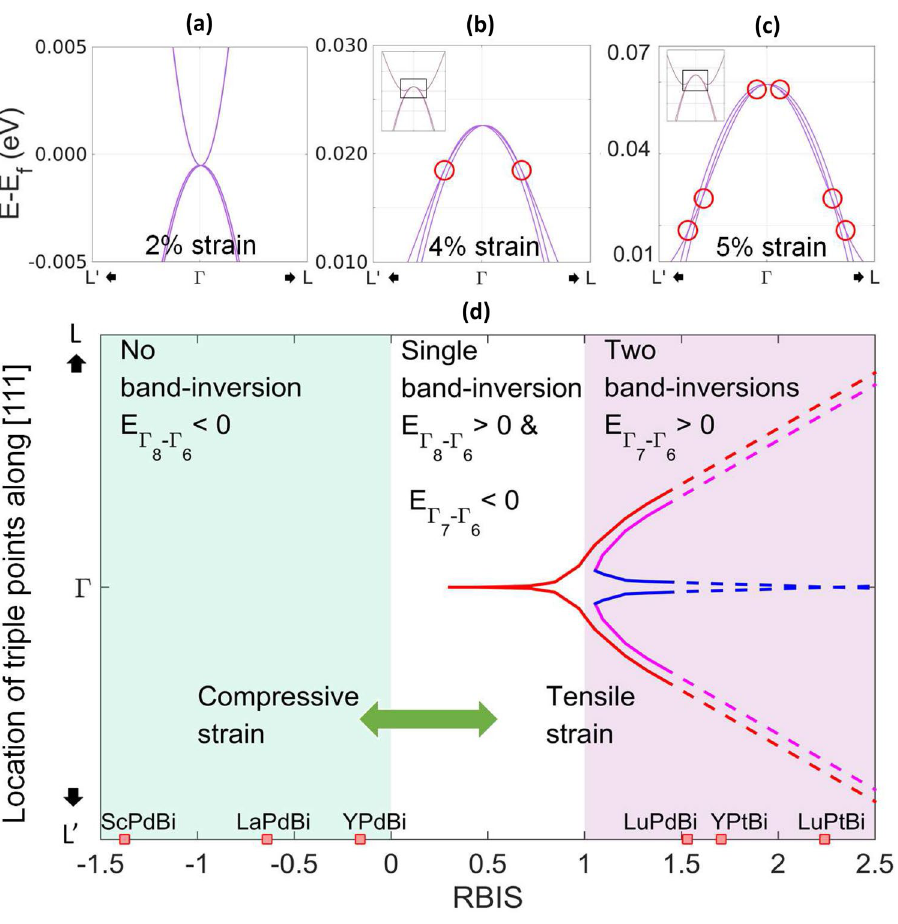
Figure 4. Triple points (marked with red circles) in YPdBi at ( a ) 2%, ( b ) 4% and ( c ) 5% tensile strain. ( d ) Trajectories of triple points in diamagnetic half-Huesler alloys as function of RBIS. The red, magenta and blue lines represent the trajectories of the outer-most, middle and inner-most triple points respectively.